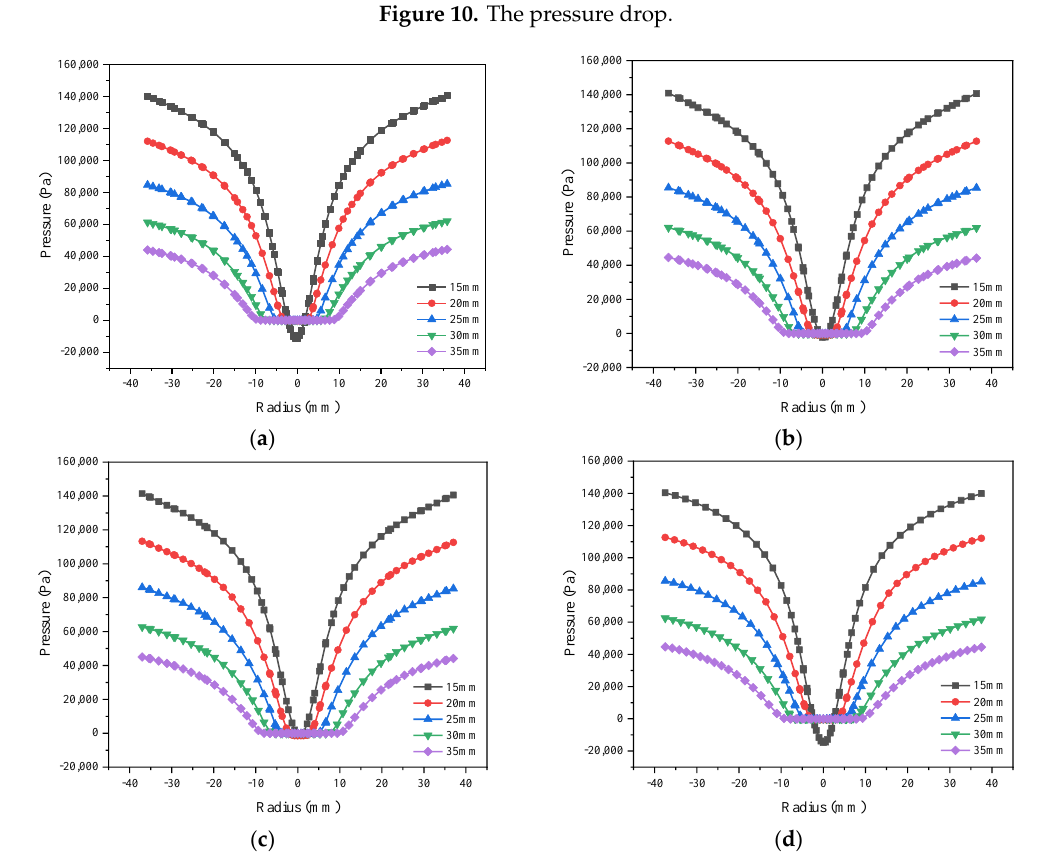
Figure 11. The radial pressure distribution: ( a ) Z = 75; ( b ) Z = 100; ( c ) Z = 125; ( d ) Z = 175.